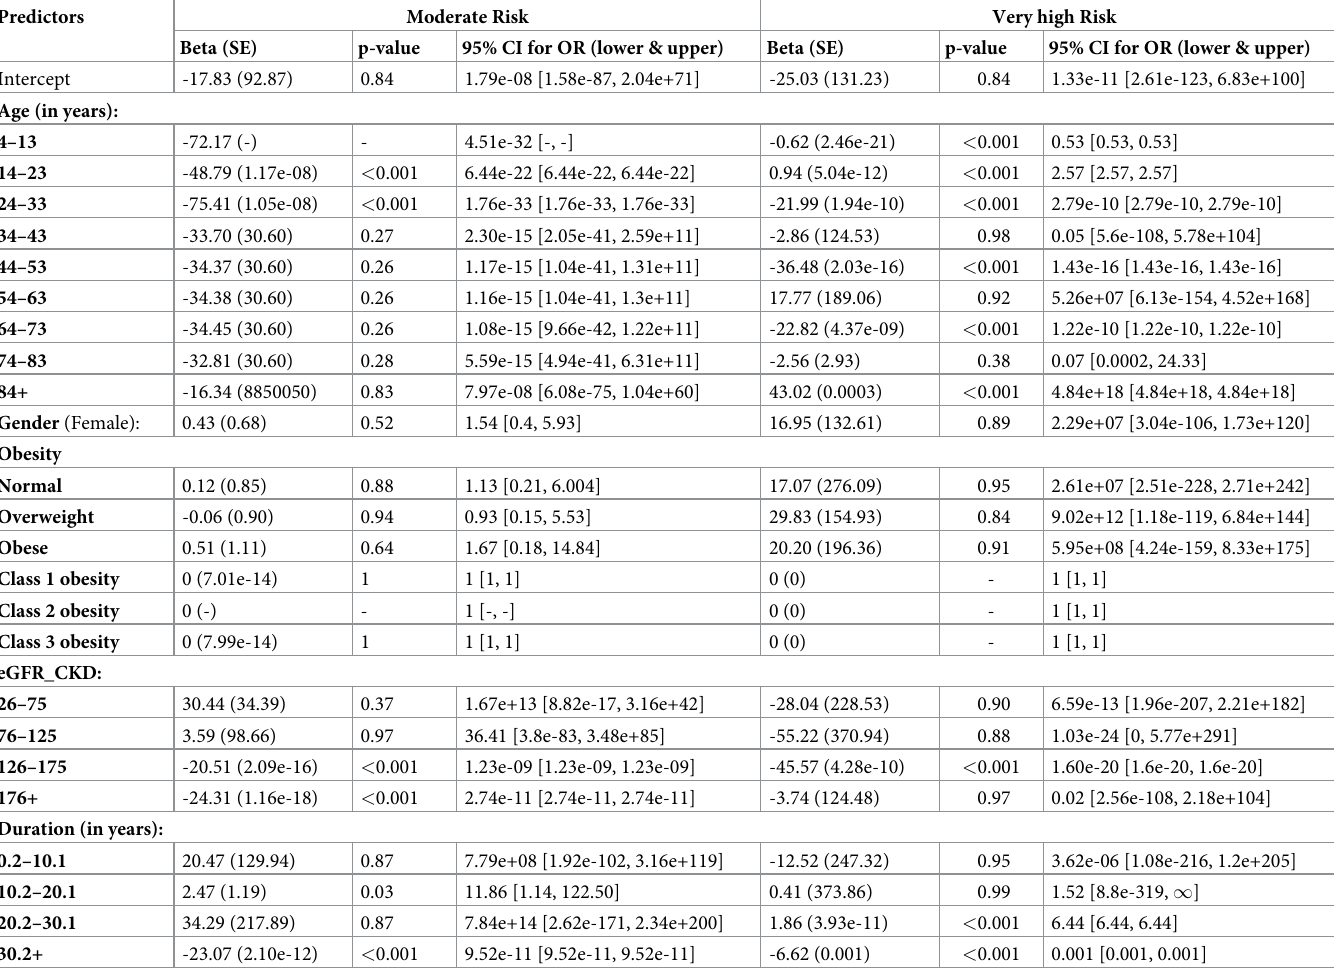
Table 2. Multinomial regression of risk of progression to CKD (with reference to low risk) with various